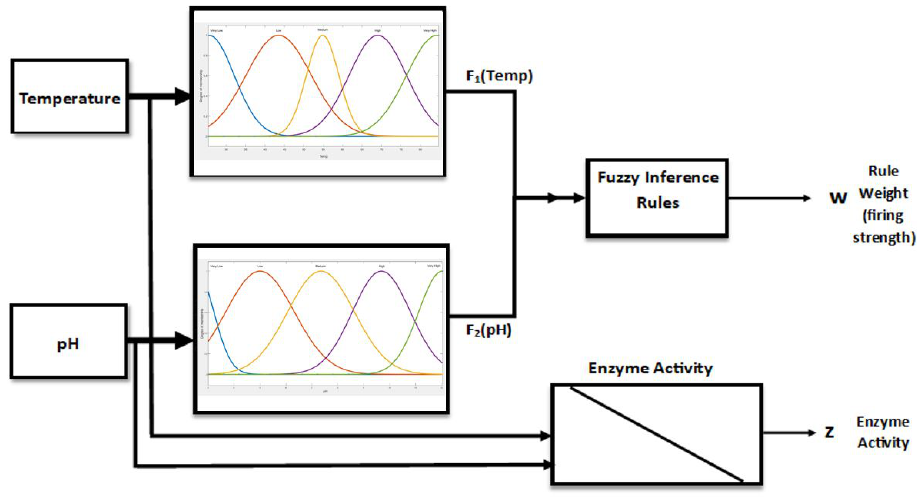
Figure 5. Multi-input single-output (pH–temp–enzyme activity) FIS structure.